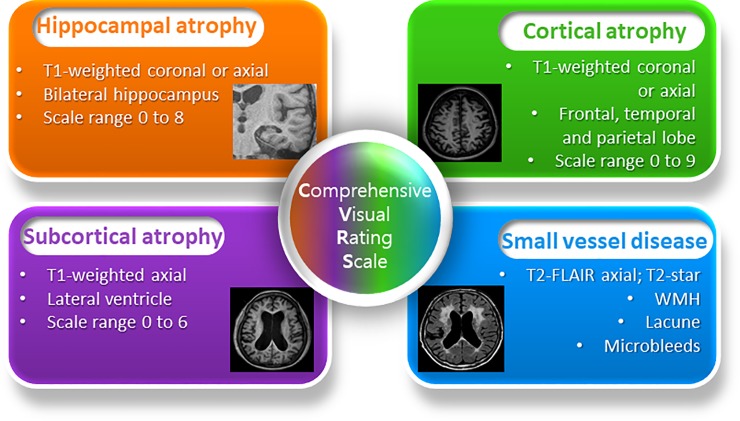
Construction of comprehensive visual rating scale(CVRS).